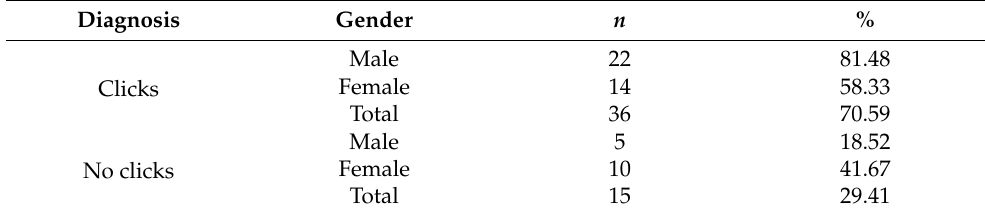
Table 3. Clicks prevalence among the studied sample, by gender.